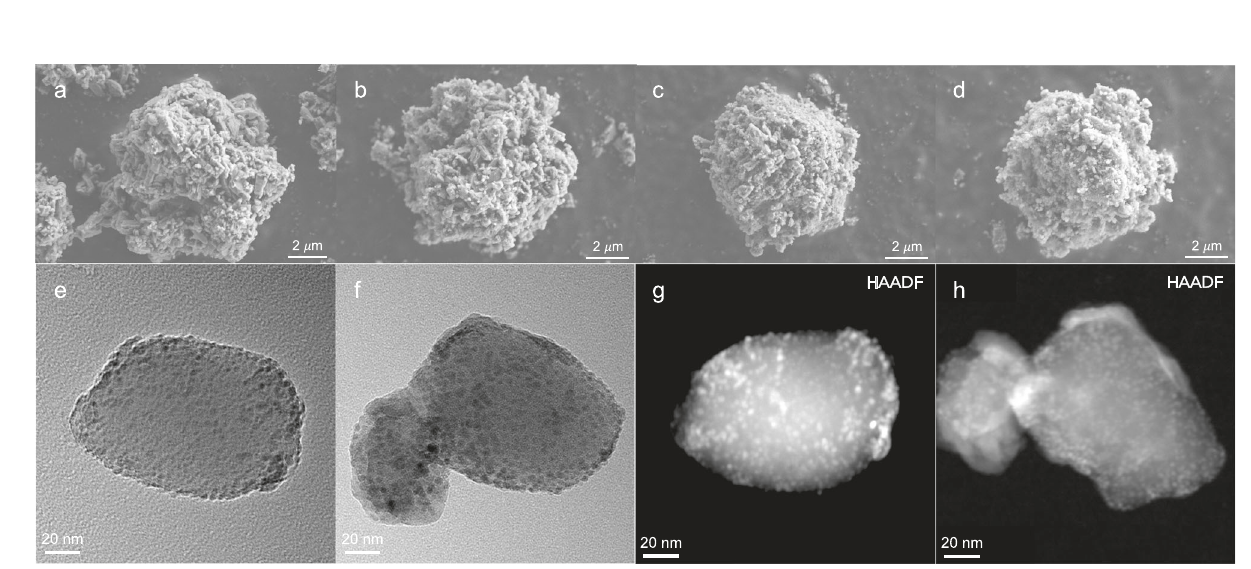
Fig.2|ElectronmicroscopyimagesoftheZSM-5_H-basedcatalysts. SEMimages (scalebar=2 μ m)ofan individual a ZSM-5_H, b Co/ZSM-5, c Ni/ZSM-5_H,and d Ru/